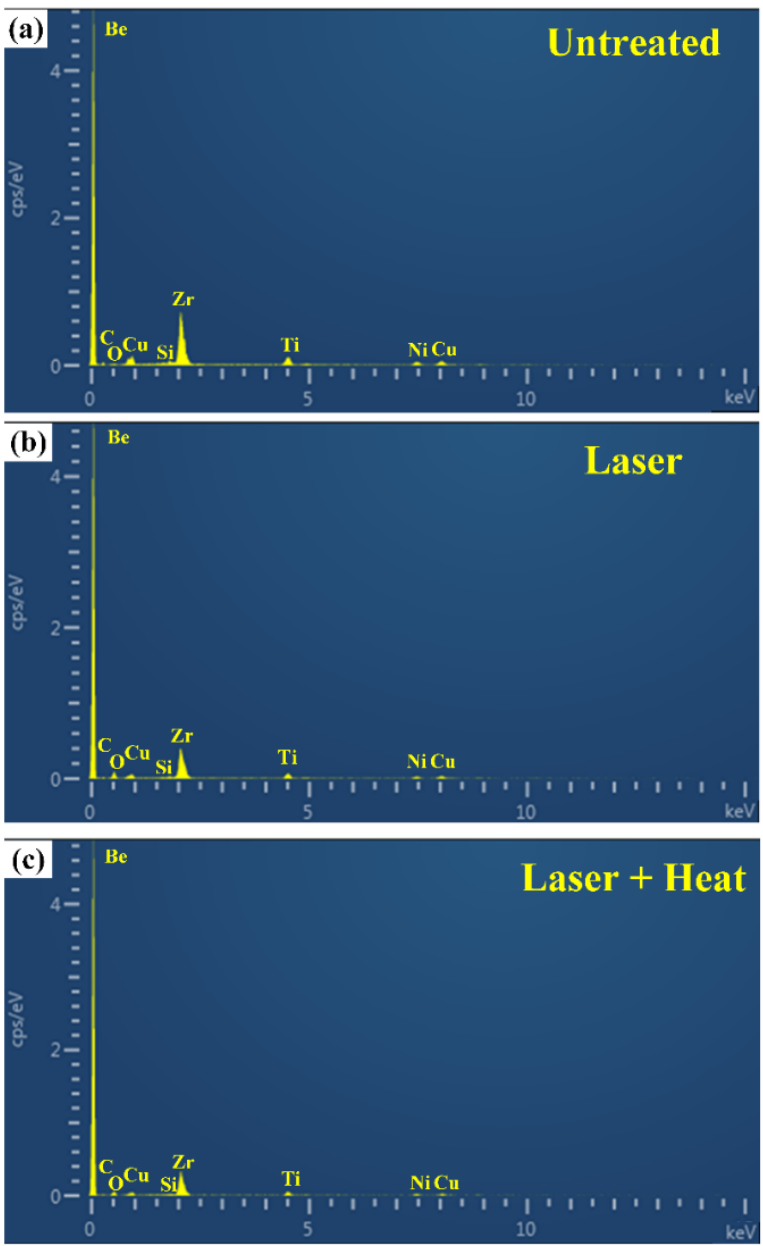
Figure 7. EDAX spectra for ( a ) untreated BMG surface; ( b ) laser textured BMG surface; ( c ) laser textured BMG surface followed by heat treatment.